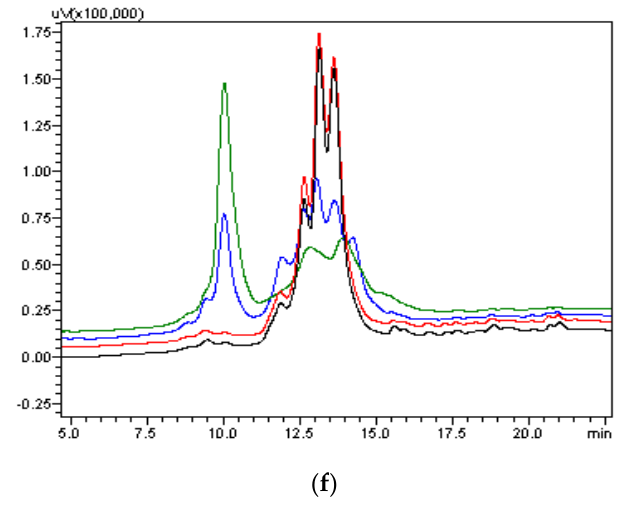
Figure 5. ( a ) VEGFR1(D1–D3)-Fc profiling using analytical RP-HPLC; ( b ) MALDI TOF/TOF MS spectra for intact mass analysis for VEGFR1-Fc peak #3; ( c ) fluorescence spectroscopic data for VEGFR1(D1–D3)-Fc; ( d ) far UV CD data for VEGFR1(D1-D3)-Fc protein; ( e ) SEC data for VEGFR1(D1–D3)-Fc; ( f ) VEGFR1(D1–D3)-Fc protein stability at 6 months by RP-HPLC. Black: − 70 °C; Red: − 20 °C; Blue: 2–8 °C; Green: 25 °C. RP-HPCL data implies protein is stable at 6 months at − 70 °C and also to a great extent at − 20 °C.